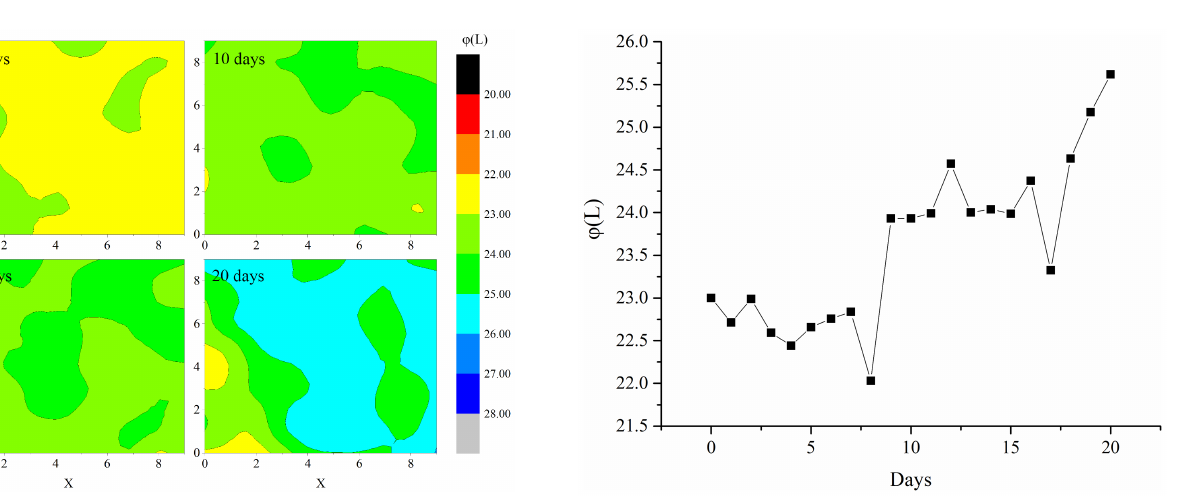
Figure 7. The changing line of the groundwater pressure head ( ϕ) estimation of grid cell (5, 5) with assimilation time. The value grows with the evolution of the